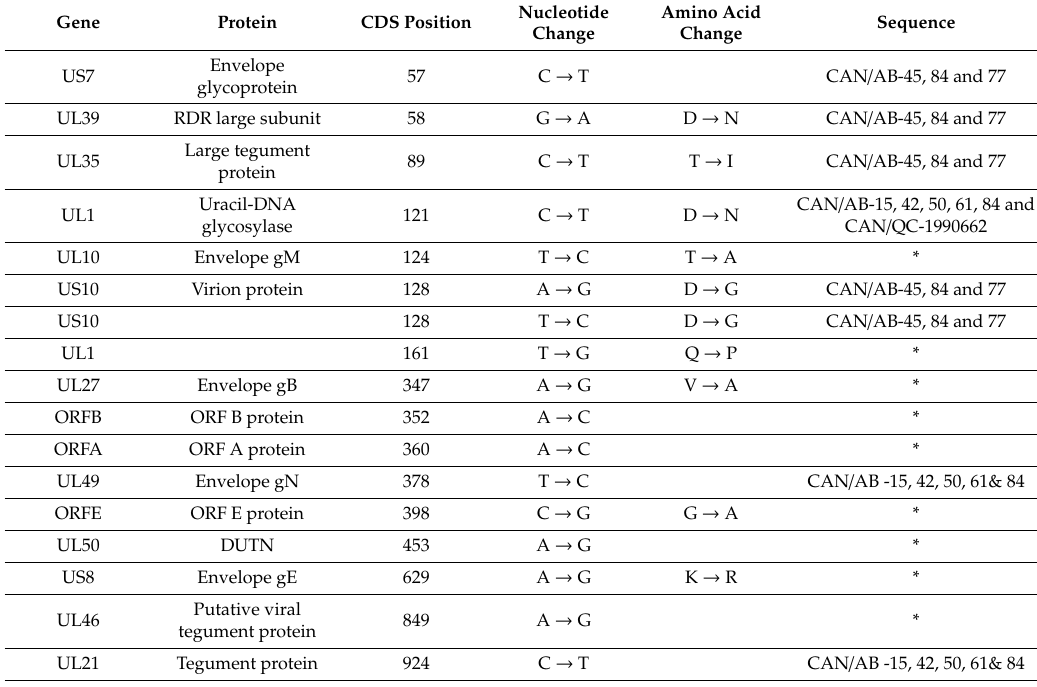
Table 3. Single nucleotide polymorphisms (SNPs) of the nine Canadian ILTV sequences from the Alberta (CAN / AB-S61, CAN / AB-S50, CAN / AB-S42, CAN / AB-T85, CAN / AB-S45, CAN / AB-S77, CAN / AB-15A, CAN / AB-S84) and Quebec (CAN / QC-1990662) provinces using the vaccine strain Serva as a reference sequence. Asterisks (*) represent all nine Canadian sequences. RDR =